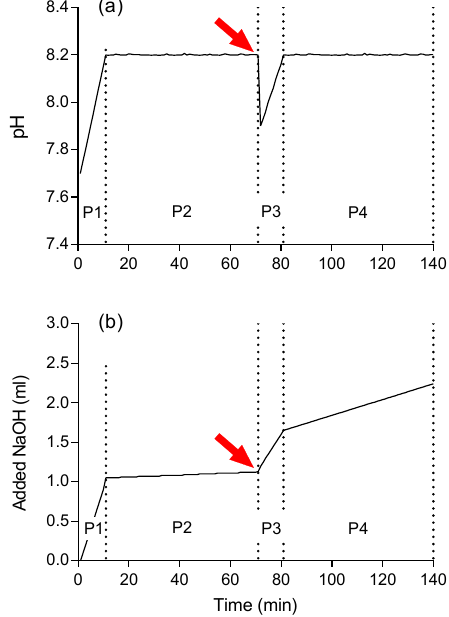
Figure 1. Typical course of ( a ) pH and ( b ) NaOH supply over time in a pH-Stat titration assay of a poly(lactic acid) (PLA) suspension as substrate and a PLA degrading enzyme. Phase 1 (P1): adjustment of the pH to 8.2. Phase 2 (P2): supply of low amounts of titrant to counterbalance an unspecific pH decrease before enzyme addition (substrate blank). Phase 3 (P3): re-adjustment of the pH to 8.2 after enzyme addition (indicated by an arrow). Phase 4 (P4): titration after enzyme addition to counterbalance a pH decrease of substrate hydrolysis (reaction) and an unspecific pH drop (blank).